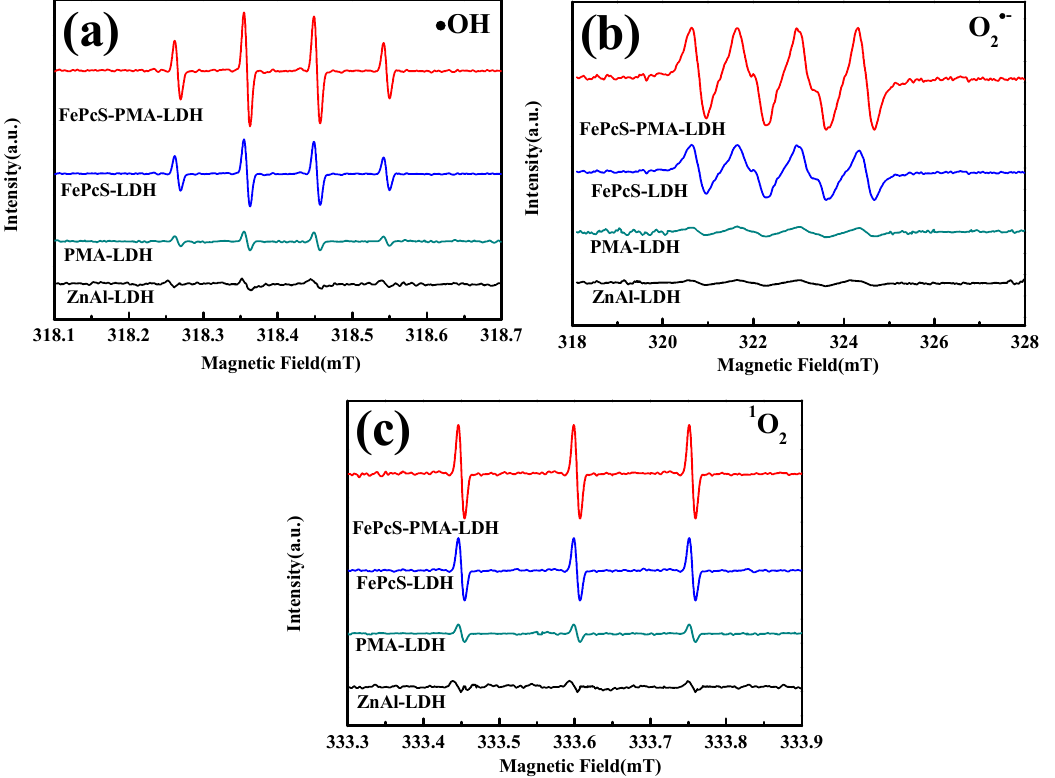
Figure 11. Electron spin resonance (ESR) spectra of ( a ) DMPO–HO · adducts, ( b ) DMPO–O 2 •− adducts and ( c ) TEMP– 1 O 2 adducts in the photo-Fenton system with ZnAl–LDH, PMA–LDH, FePcS–LDH, and FePcS–PMA–LDH under visible light irradiation.